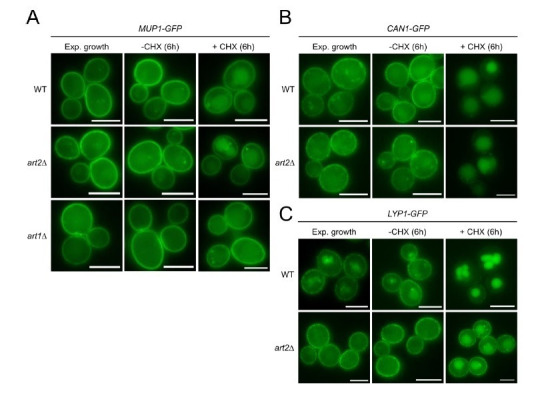
Life cell fluorescence microscopy of WT, art2Δ or art1Δ cells chromosomally expressing Mup1-GFP (A), Can1-GFP (B) or Lyp1-GFP (C) during exponential growth and 6 hour after treatment with 50 μg/ml cycloheximide (+CHX) or vehicle (water; -CHX).